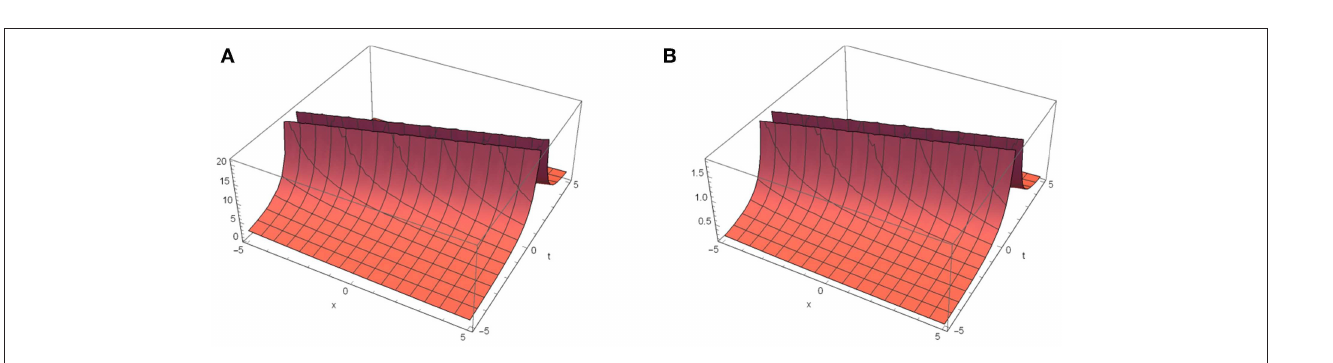
for k 2 0.2, k 3 | =